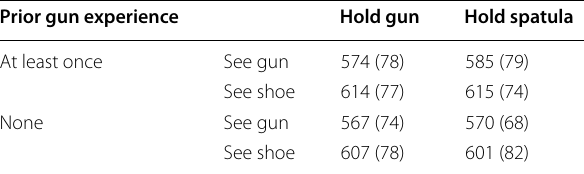
Table 2 Mean proportion of correct responses (and between-subject standard deviations) for Experiment 2 Prior gun